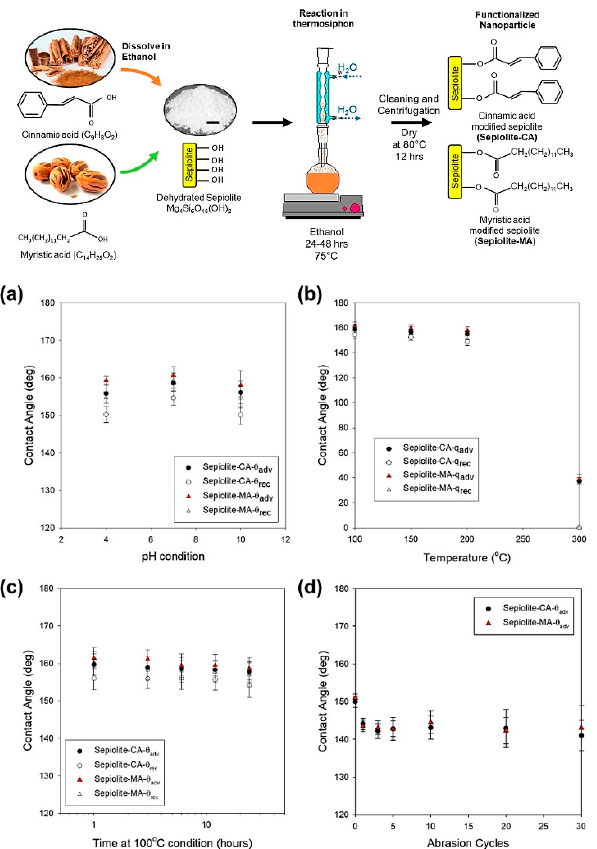
Figure 4. Functionalization procedure of the sepiolite nanoparticles with CA or MA. Step (1) dehydration of the sepiolite particles, (2) acid solution preparation with ethanol, (3) functionalization reaction in a thermosiphon, and (4) cleaning and separation of nanoparticles from the reacted solution. Scale bar in the dehydrated sepiolite image is 2 mm. Durability of the coating as characterized by the apparent advancing and receding contact angles ( a ) after full immersion in different pH conditions (pH 4, pH 7, and pH 10), ( b ) at elevated temperature conditions up to 300 ◦ C, ( c ) as a function of time during exposure to 100 ◦ C in atmospheric conditions for up to 24 h, and ( d ) after repeated mechanical abrasion cycles. Measurements were done on 5 independent spatial locations for each sample. Error bars represent standard deviation of the 5 independent measurements. Reprinted with permission from [49] 2019 ACS